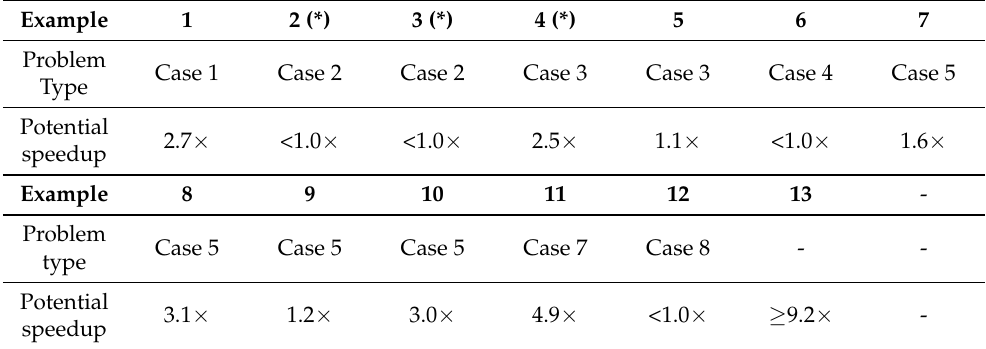
Table 7. Summary of the potential speedups for Examples 1–13. Examples of questionable significance are marked with ( ∗